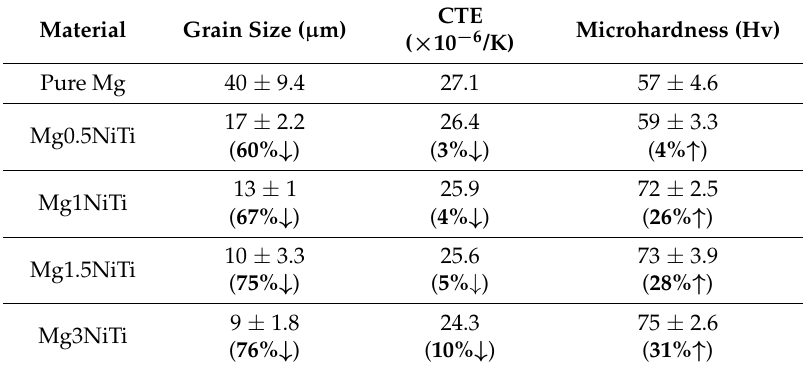
Table 2. Grain size, CTE and microhardness of Mg-NiTi nanocomposite samples.